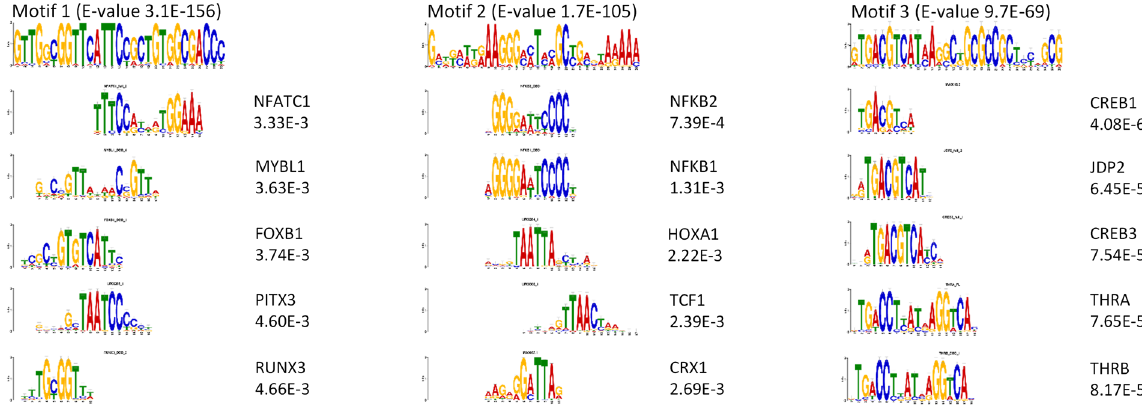
Figure 5. Motif enrichments of differentially methylated regions located near transcriptional start sites. Three most significant motifs as analysed by MEME-ChIP with their respective E-values. Top 5 list of predicted transcription factors from each motif as analysed by Tomtom with their respective P